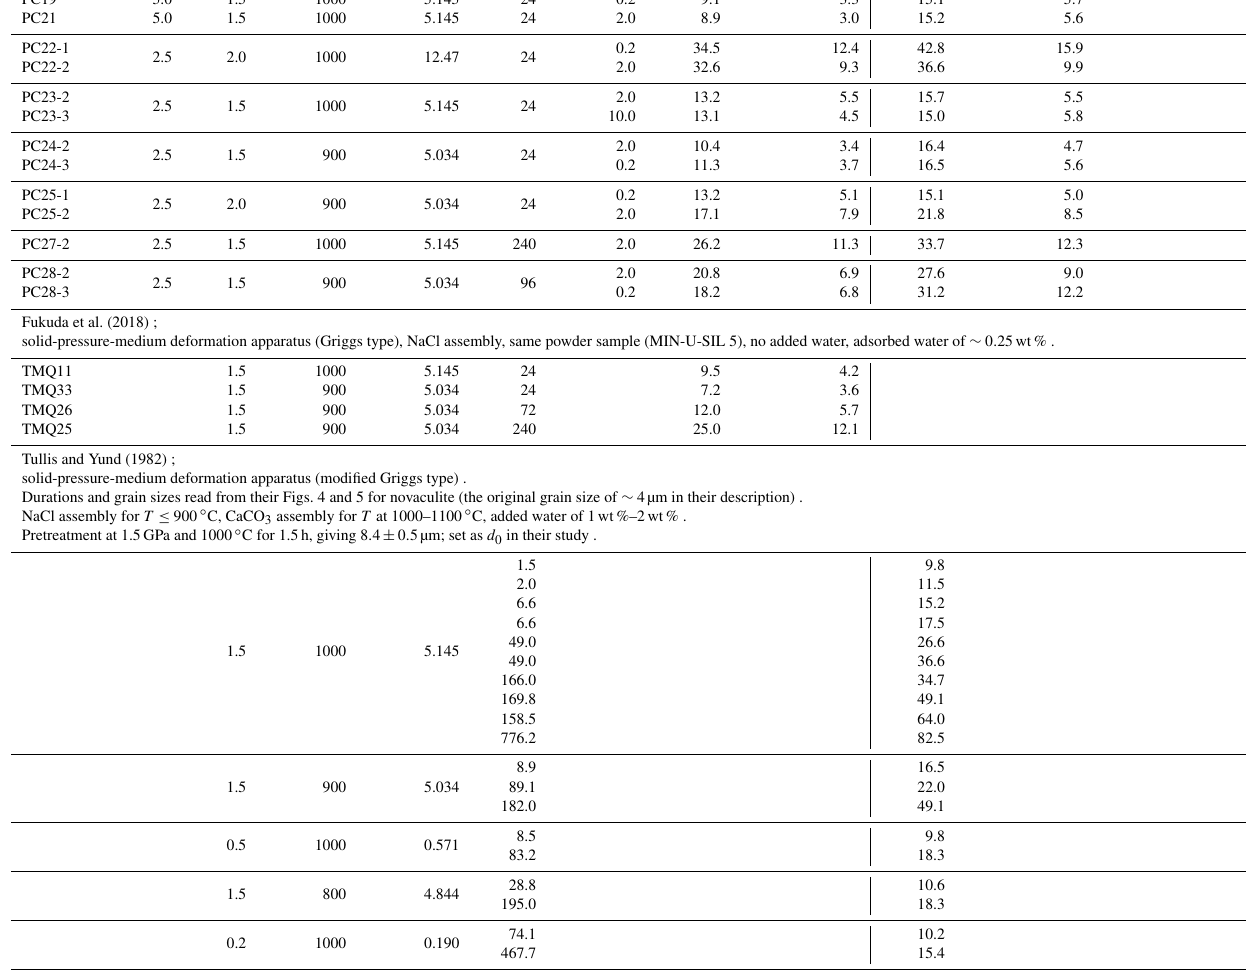
Powder Novaculite